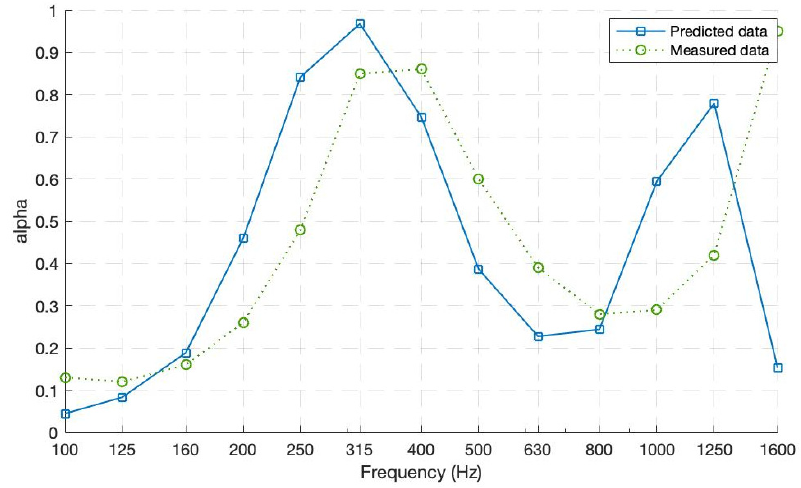
Figure 11. Absorption coefficients for Prototype 2—Double layer with four parallel-arranged MPPs each.